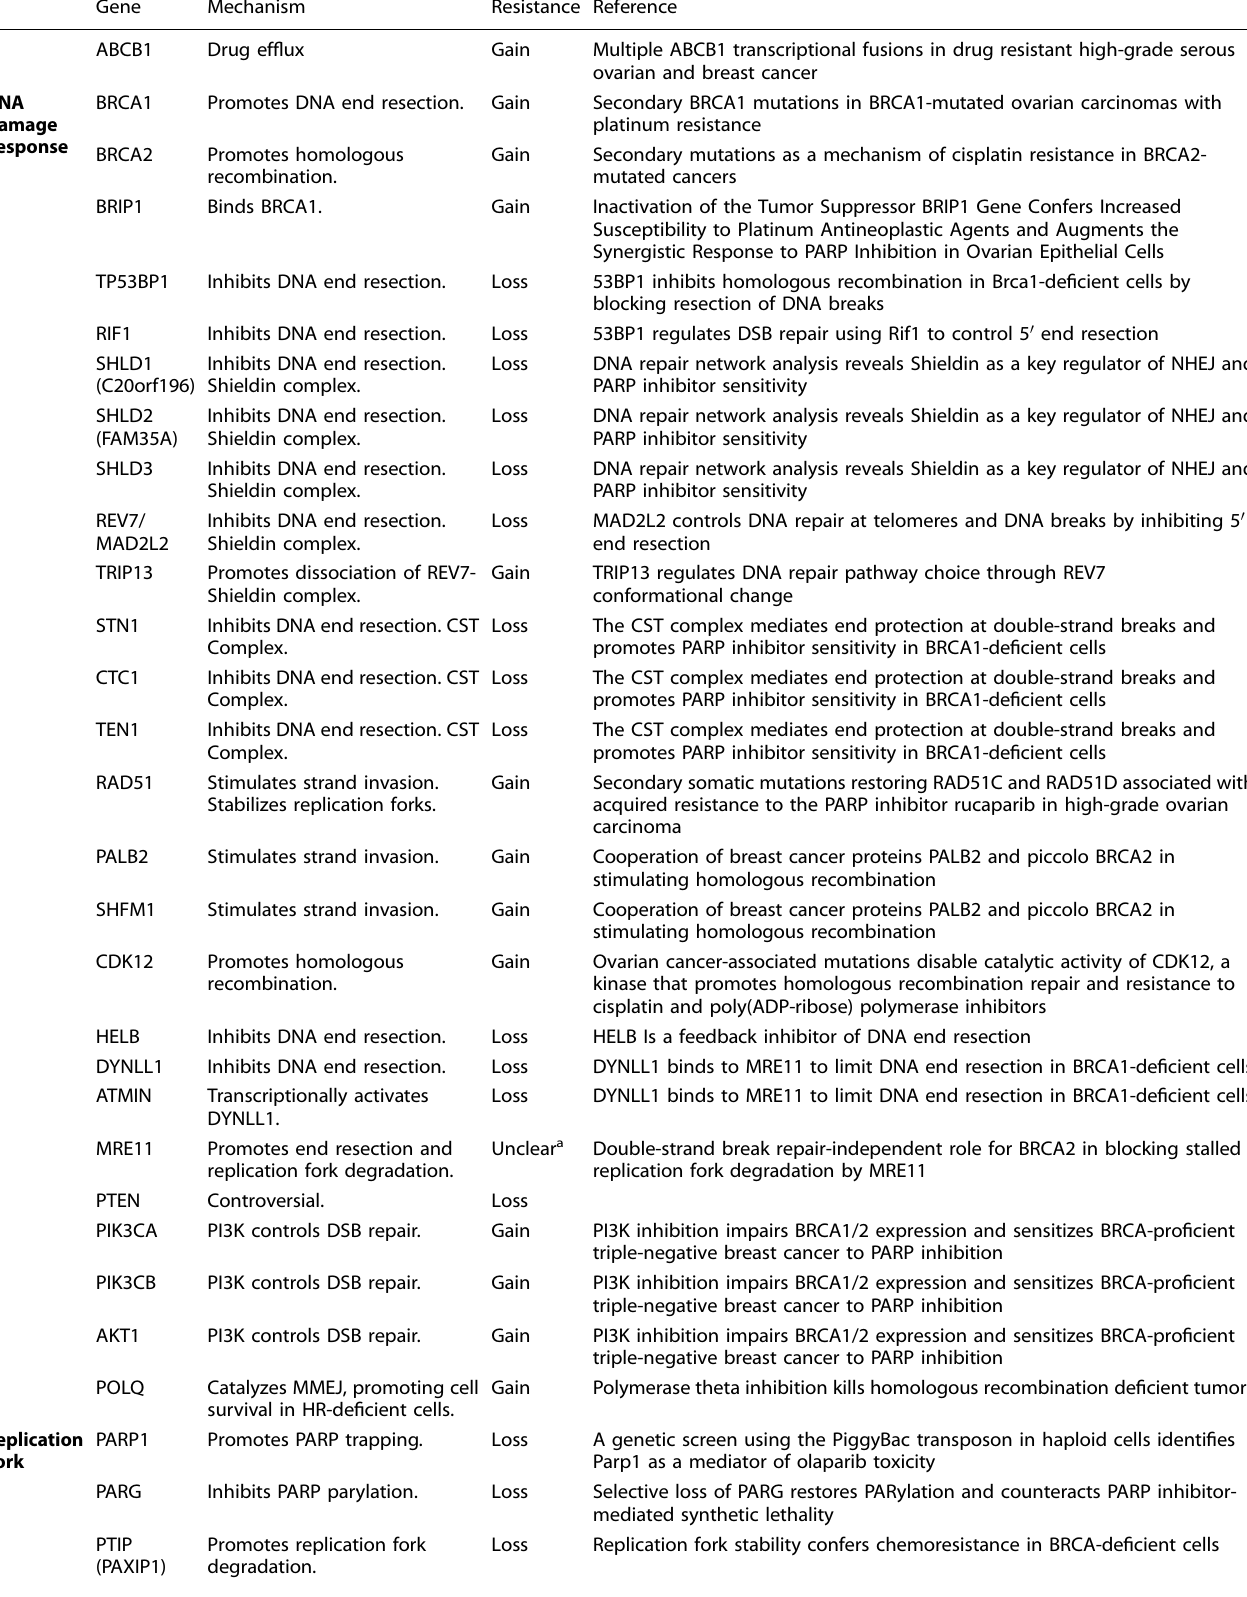
Table 2. Mechanisms of resistance. Gene